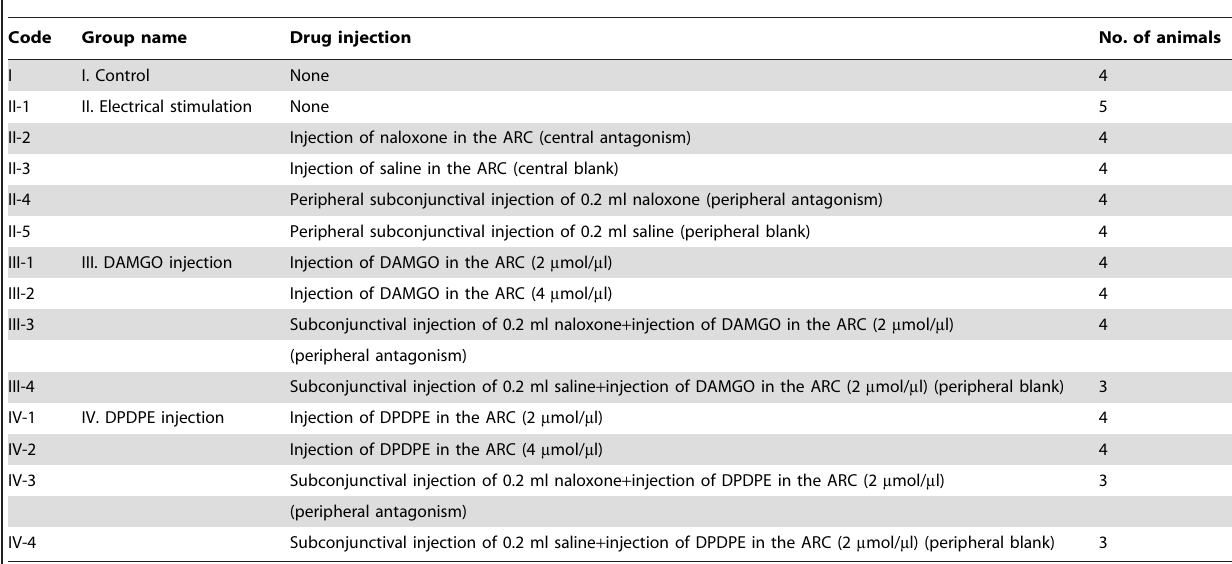
Table 1. Groups of animals used in each experiment (total n